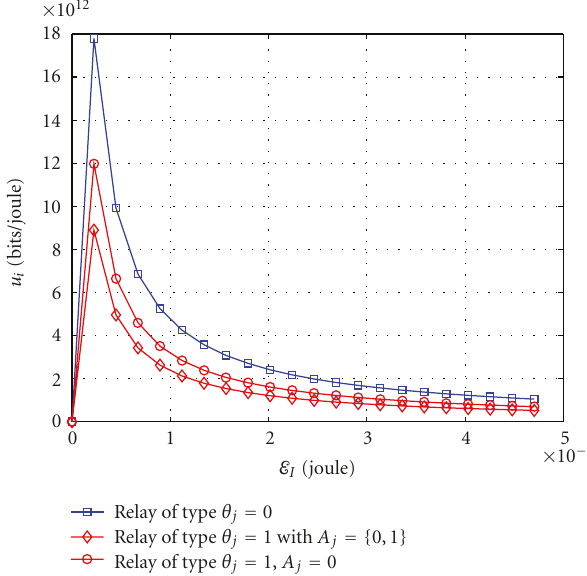
Figure 10: Utility of source terminal i as a function of total energy expended for cooperative transmission of information bearing signal. It can be observed that utility of the source terminal degrades in the presence of a selfish terminal.